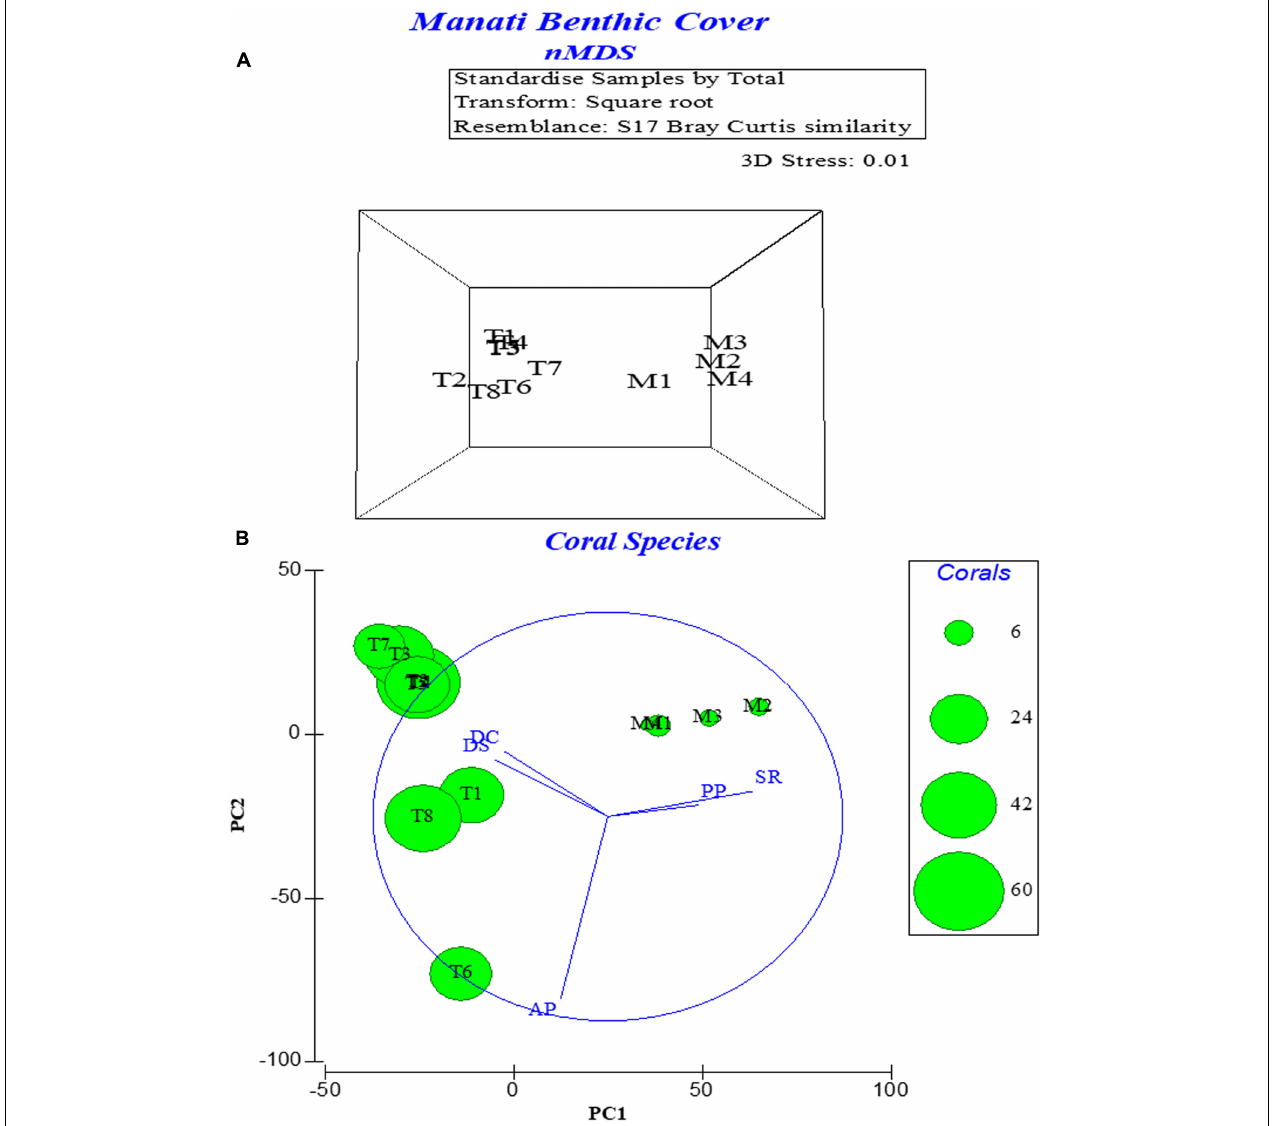
FIGURE 7 | Multivariate statistical analysis of benthic cover data. (A) nMDS 3-D plot showing the separation of both sites transects obtained with the Bray-Curtis resemblance matrix and based on the dominance of major categories. (B) PCA plot based on the distribution of hard coral and milleporid species at both sites. PC1 accounted for 53.8% of the variation and PC2 accounted for 30.7% of the variation. T, Tómbolo transects; M, Machuca transects.